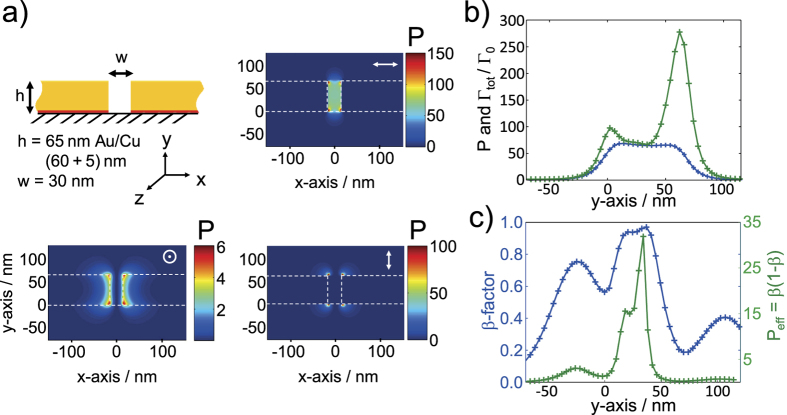
Coupling of emitters to the plasmonic slot mode.(a) Purcell factor P of the plasmonic slot-stripe waveguide for three linearly independent orientations of the emitters’ dipoles calculated with equation 230. A dipole orientation along x features high P’s in the entire slot. (b) Purcell factor P (blue) and the normalized total decay rate Γtot/Γ0 (green) for an emitter’s dipole oriented along x, centered in the slot and scanned along y. (c) Corresponding β-factor (blue) and - for comparison with Chang et al.4 - the ‘effective Purcell factor’ Peff = β(1 − β) (green) also as a scan along y.